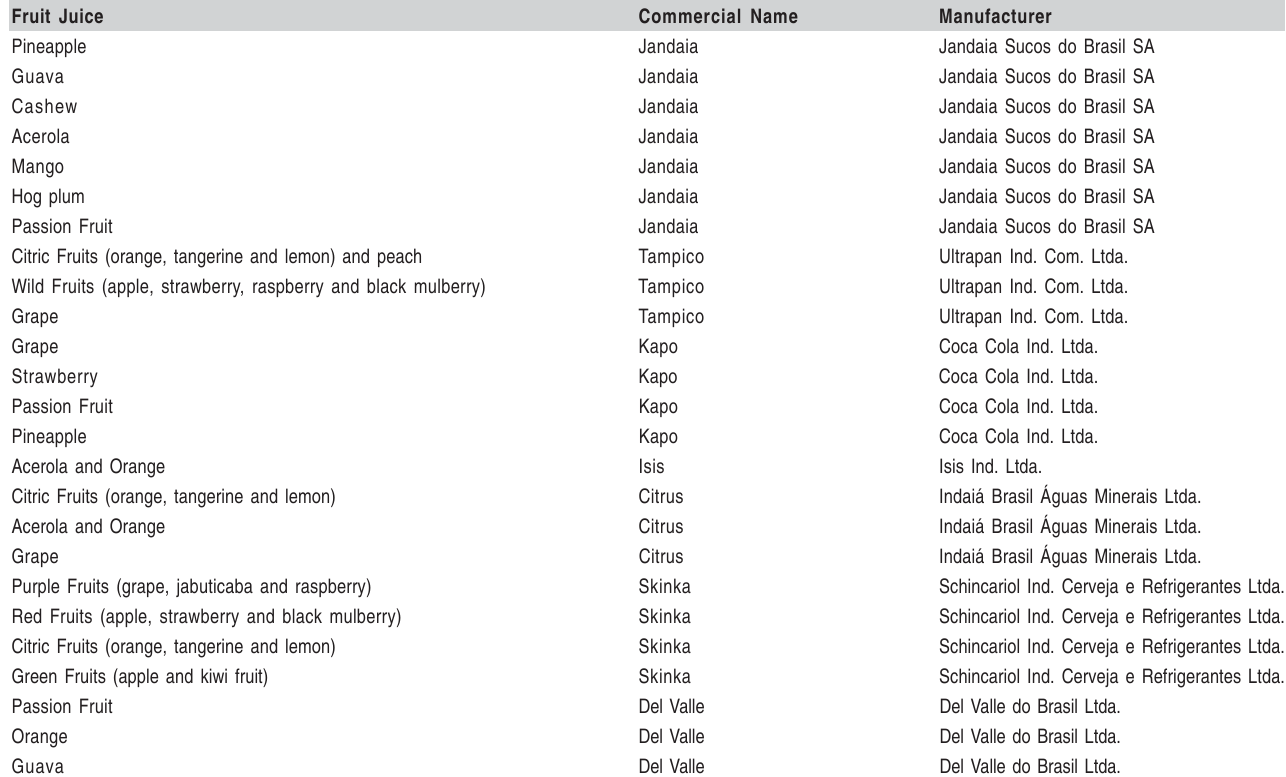
Table 1. Fruit juices, commercial name and manufacturers.